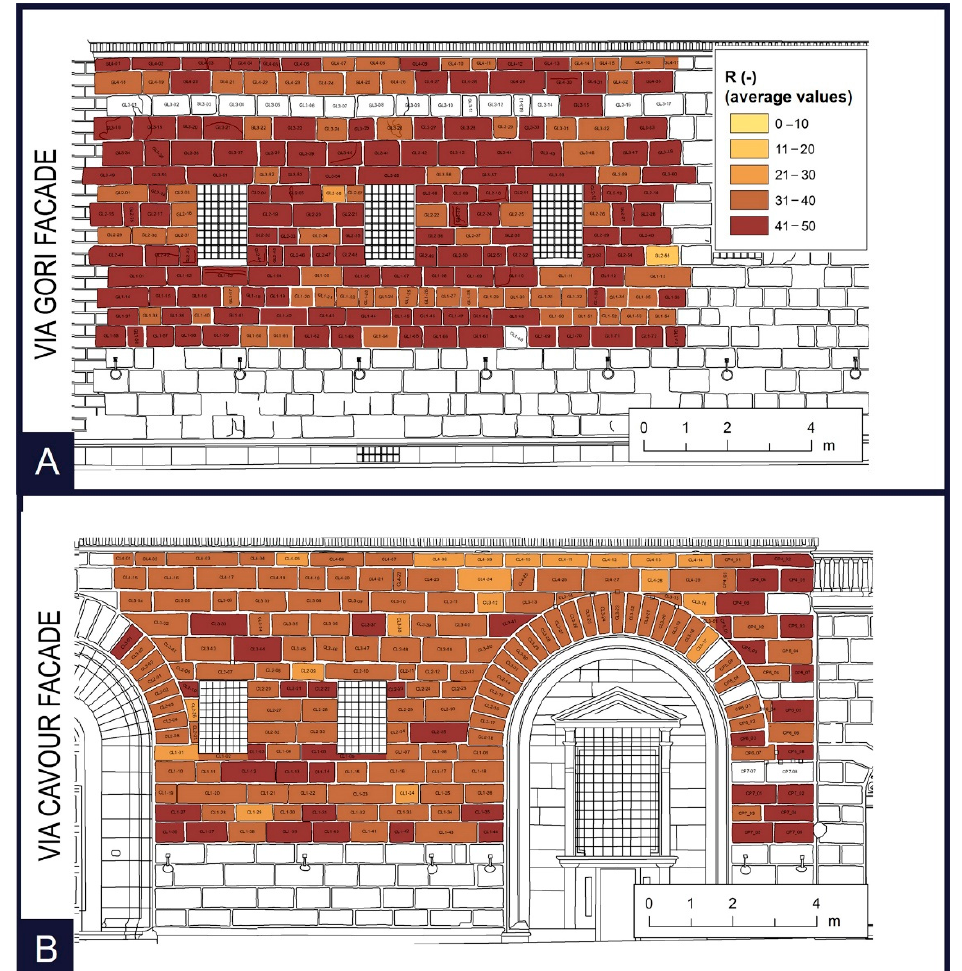
Figure 10. Average R value maps processed through GIS software, related to blocks on ( A ) Via Gori and ( B ) Via Cavour.